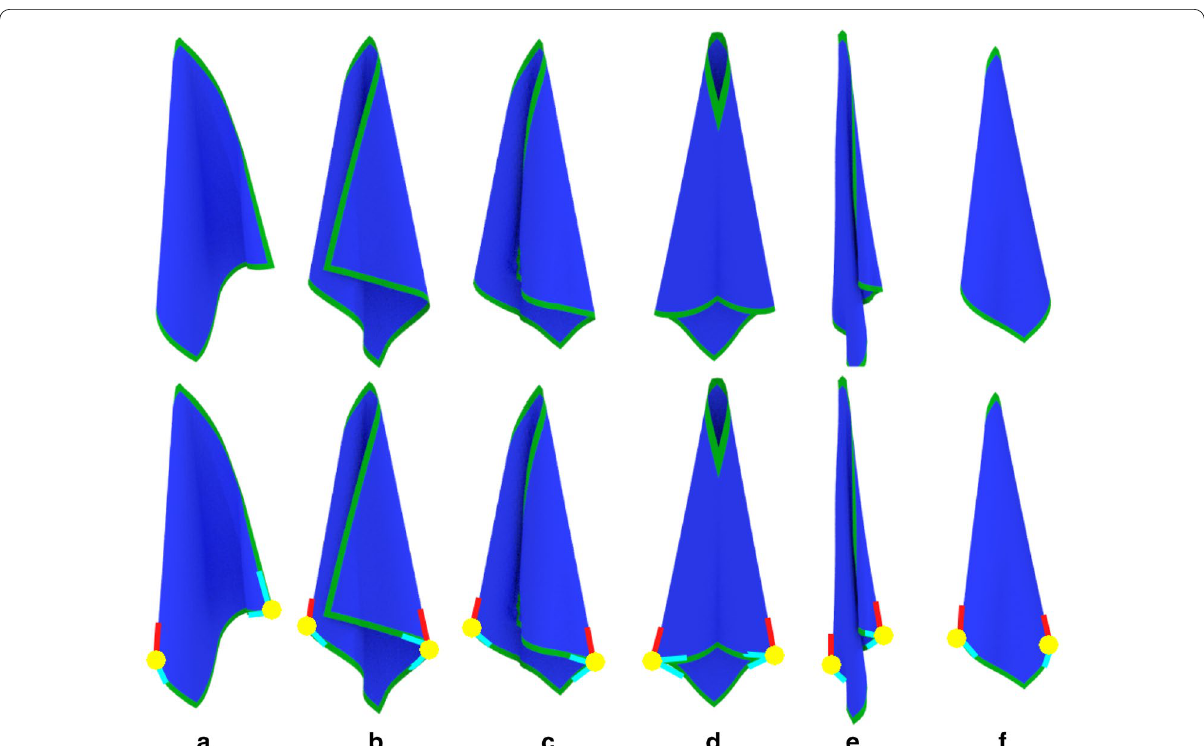
Fig. 5 Synthetically generated examples of folding patterns: a has a backward fold on the left and a physical corner on the right; b has a backward fold on the left and a forward fold with a visible corner; c is the same as b but the corner is not visible; d has forward folds with non-visible corners on both sides; e has a backward fold on the left and forward fold on the right with a hidden corner; and f has backward folds on both